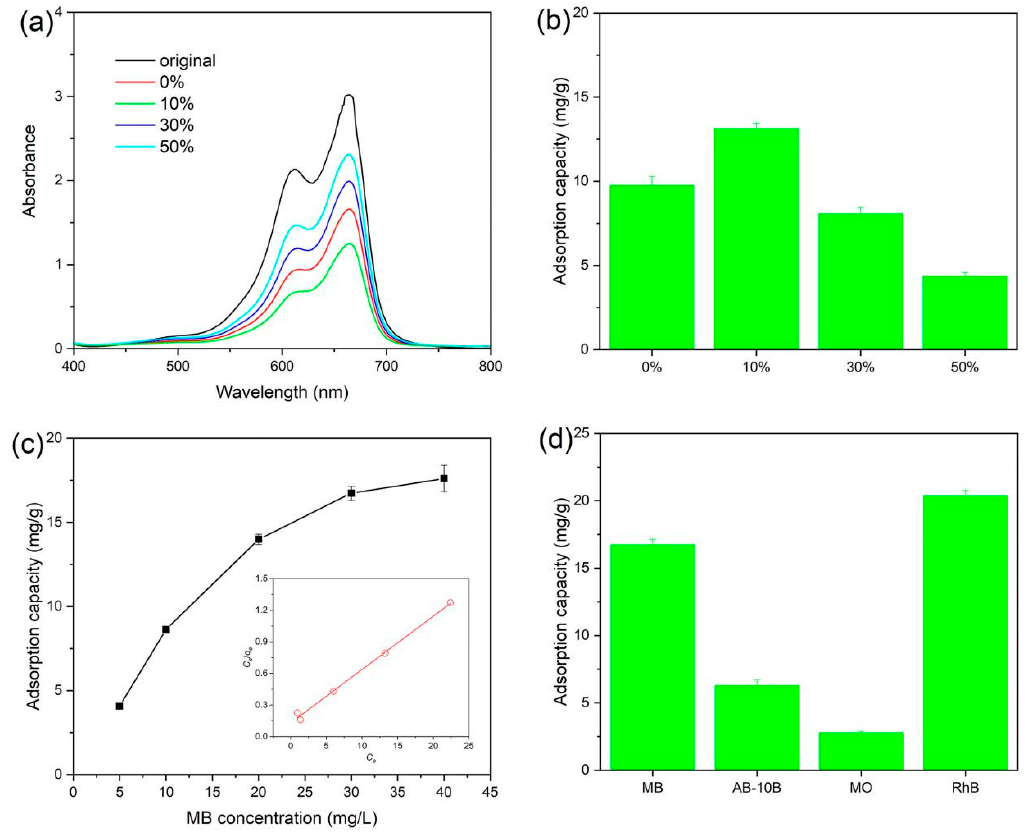
Figure 7. Adsorption capacity of RGO/BiOCl/TiO 2 nanocomposites: ( a ) UV–vis absorption spectra